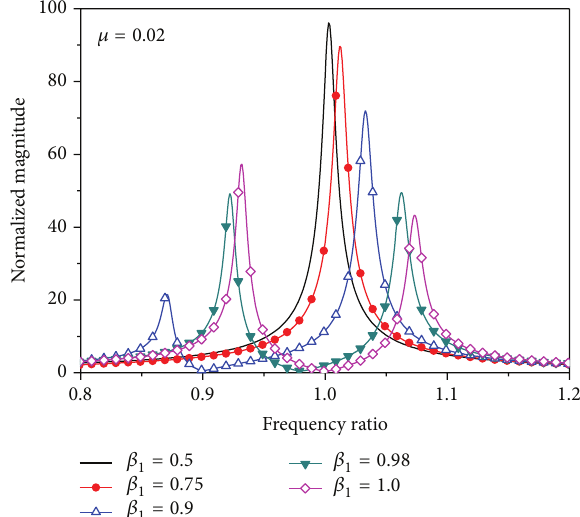
Figure 3: Large beam structure used in the present study.